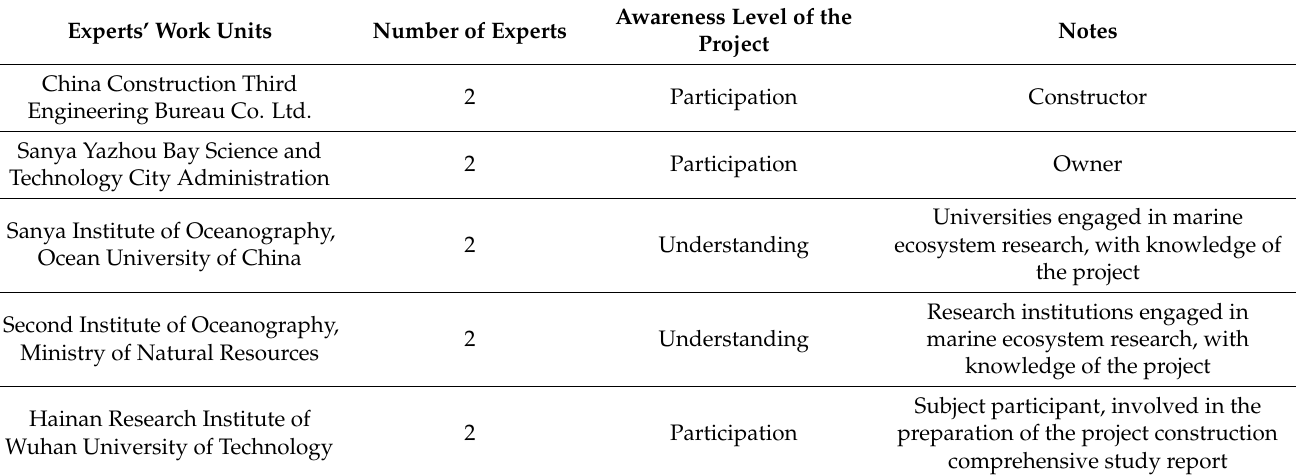
Table 3. The specific information of